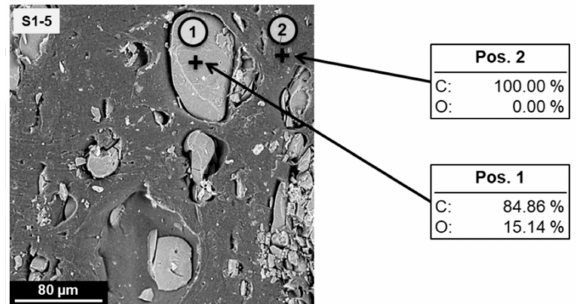
Figure 2. SEM micrograph of the cross section of an injection moulded test specimen of the formulation S1-5 with spots (1) and (2) indicating positions for the EDX analysis. The detected atomic percentages of carbon (C) and oxygen (O) are shown for each